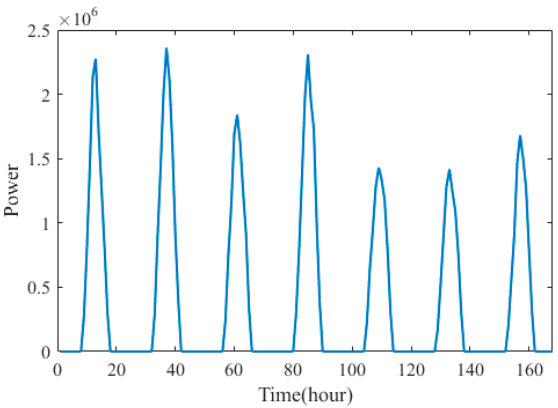
Figure 2. The representation of the power demand.